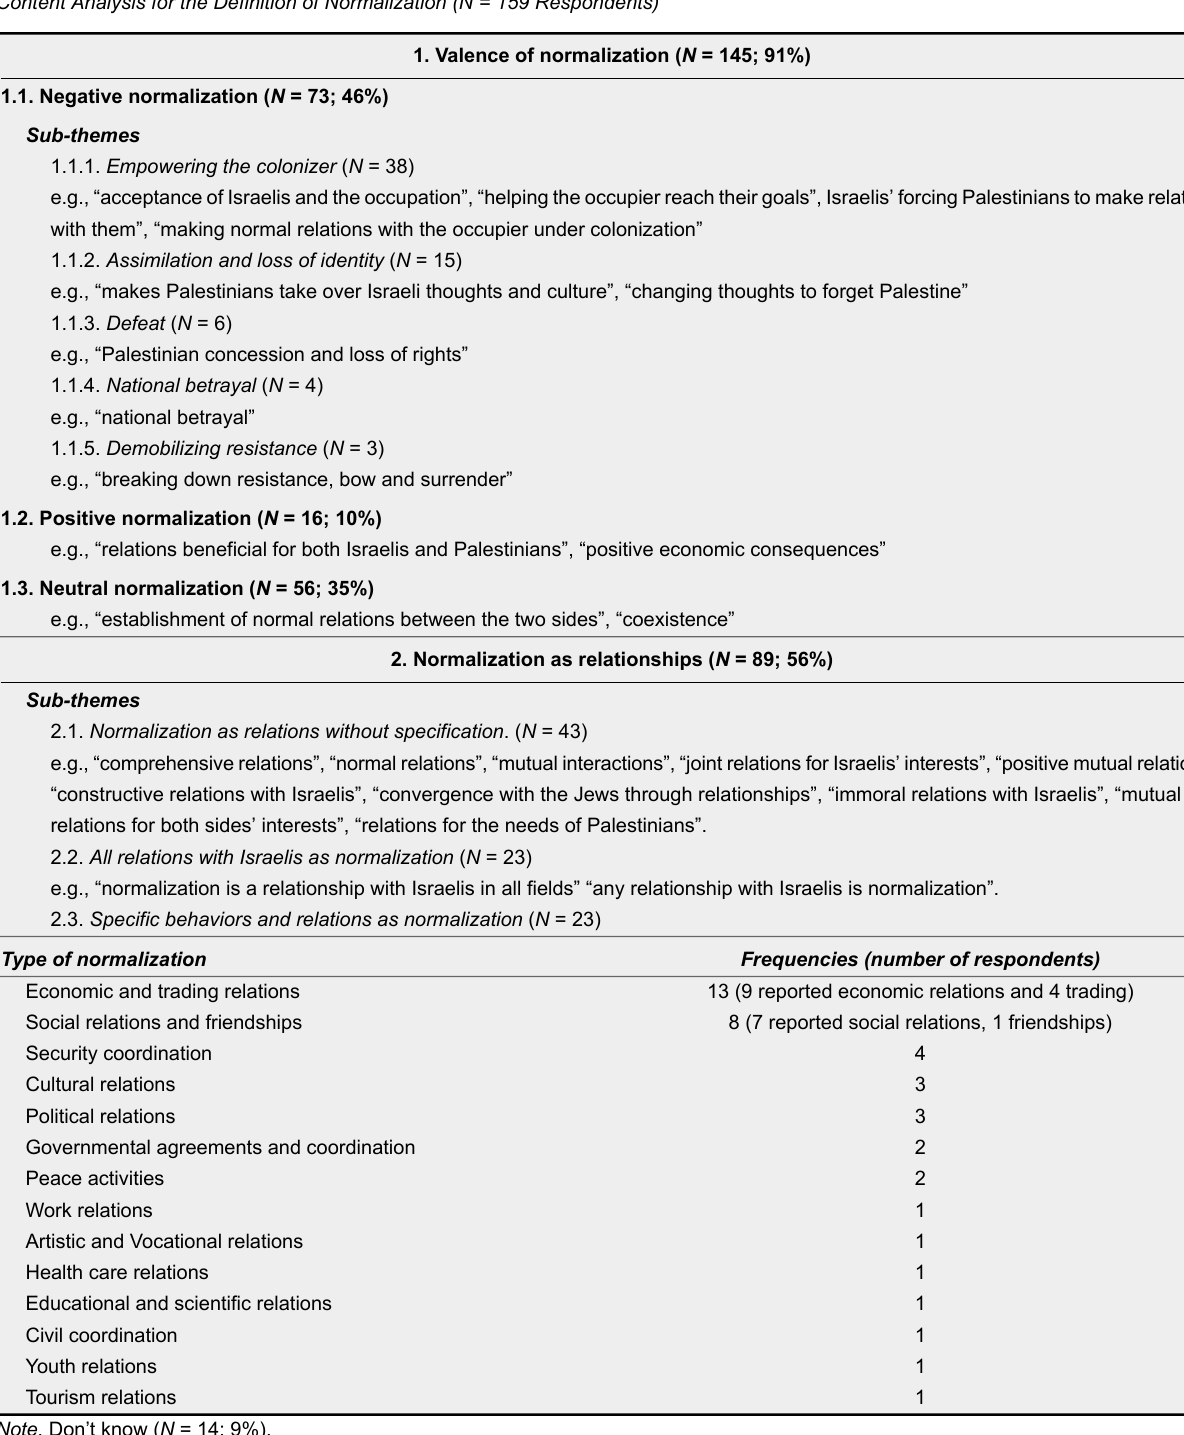
Content Analysis for the Definition of Normalization (N = 159